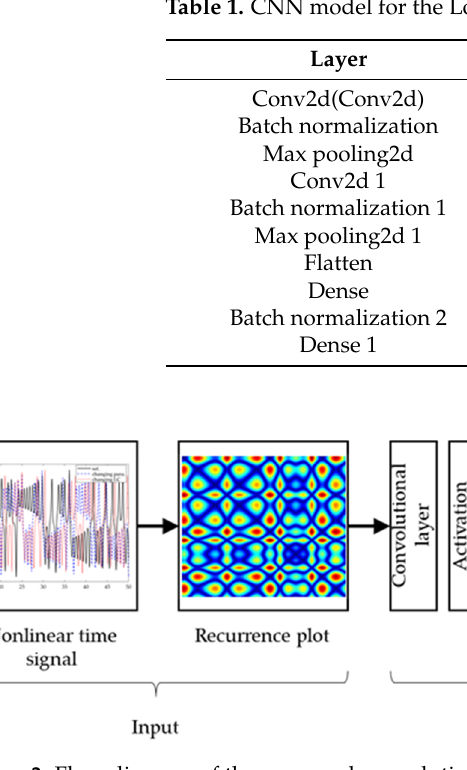
Figure 3. Flow diagram of the proposed convolutional neural network (CNN) model for the Lorenz system. Table 1. CNN model for the Lorenz system.